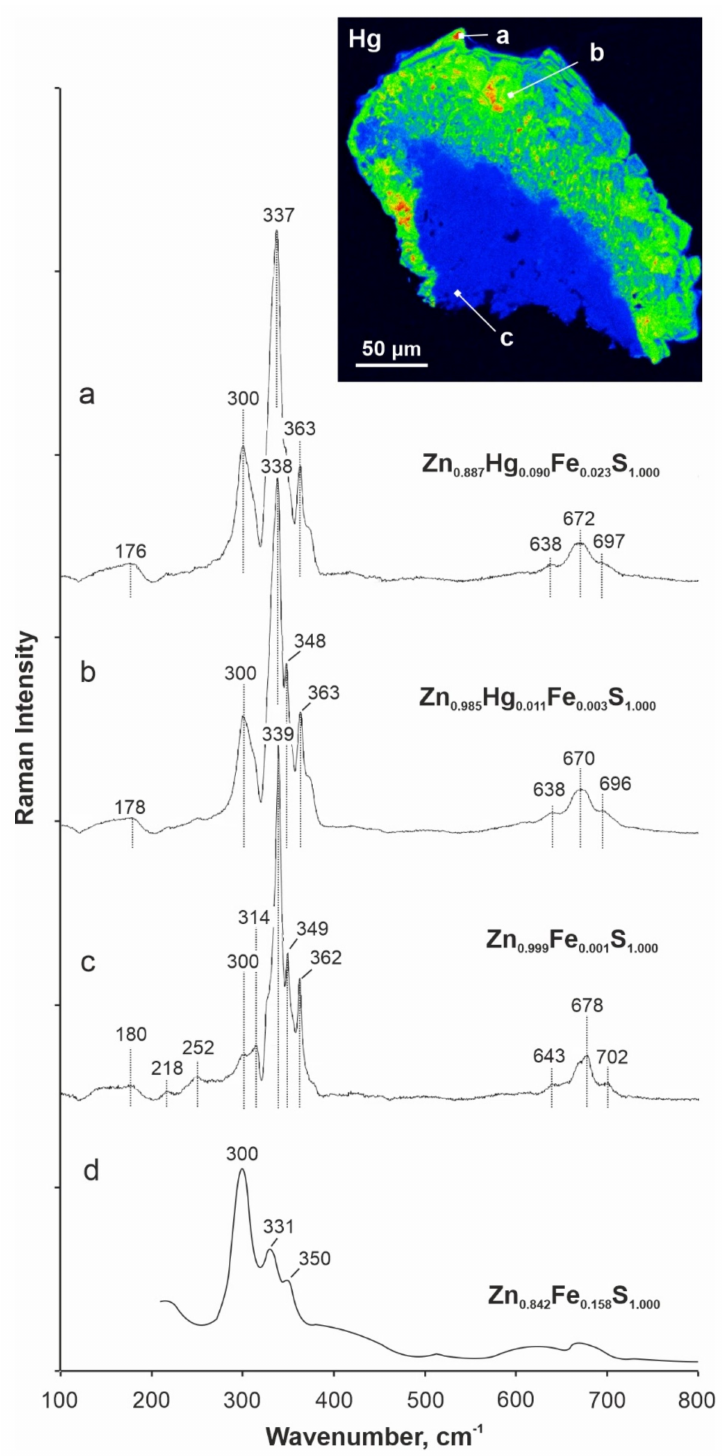
Figure 19. Raman spectra of high- ( a ) medium- ( b ) and low-Hg ( c ) sphalerite from South Sakhalin MV (grain 9-6, sample US-18-6-1) compared with Fe-enriched sphalerite ( d ) from Romania [72]. For details of Hg distribution see Figures 11 and 13. For sphalerite compositions see Tables 4 and